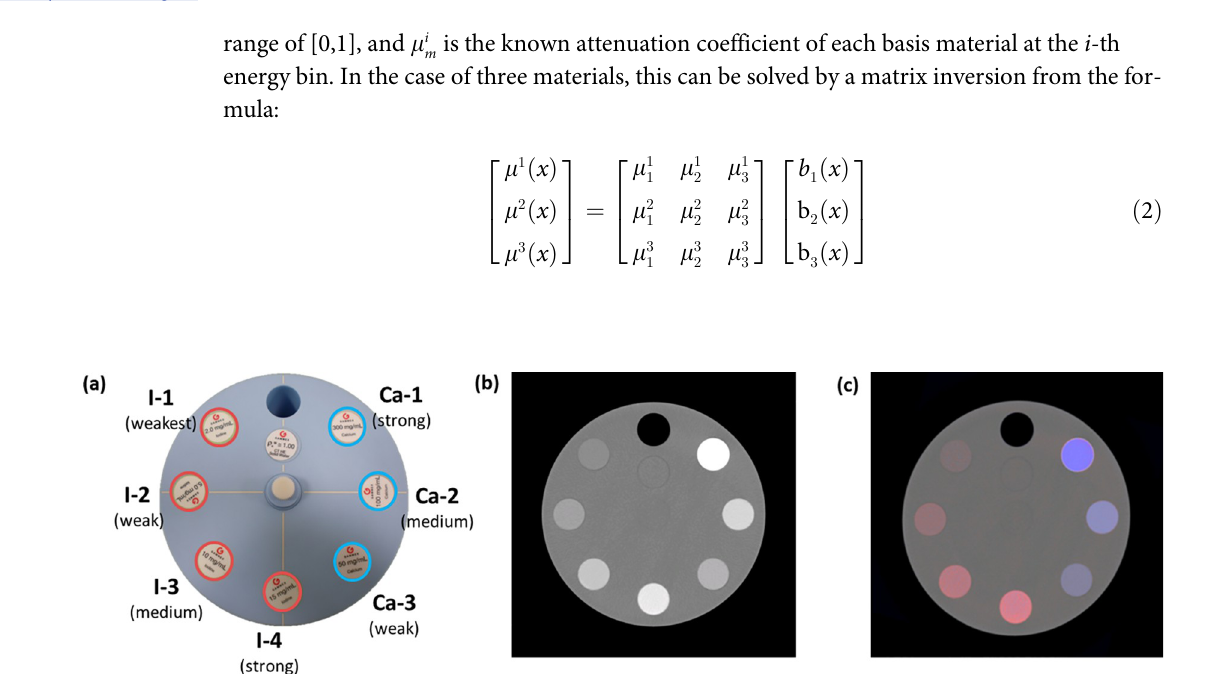
Fig 3. (a) Cylindrical PMMA phantom with 150 mm diameter and (b) transaxial image at a single-channel image for the 30–140 keV energy level. The phantom was specifically designed for basis material calibration and contained drilled holes filled with iodine (I) and gadolinium (Gd) at several concentrations: iodine (I-1: 3.7 mg/mL, I-2: 10.1 mg/mL, I-3: 18.9 mg/mL) and gadolinium (Gd-1: 3.0 mg/mL, Gd-2: 7.5 mg/mL, Gd-3: 13.8 mg/mL).